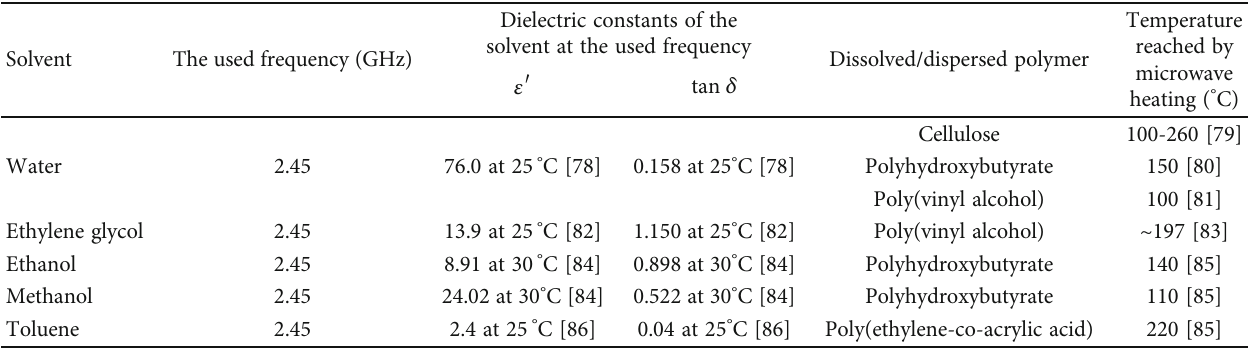
Table 2: Systems used to heat polymers in solution.